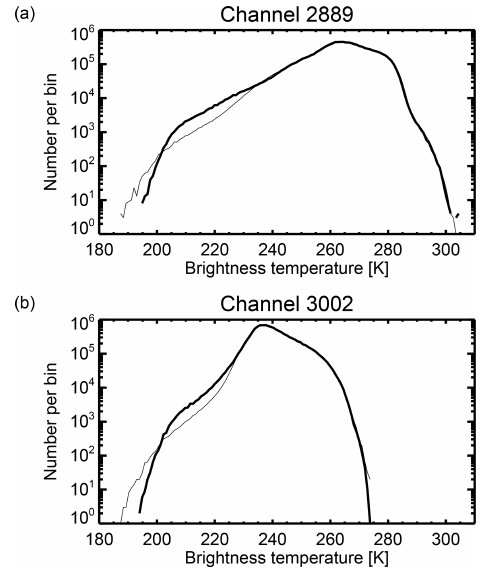
Figure 9. Histograms of brightness temperatures from observation (thick) and bias-corrected background simulation (thin) for lowest- (a) and highest-peaking (b) WV channels. Based on all available observations from 1 to 20 June 2017 excluding only high orography ( > 2500m) and